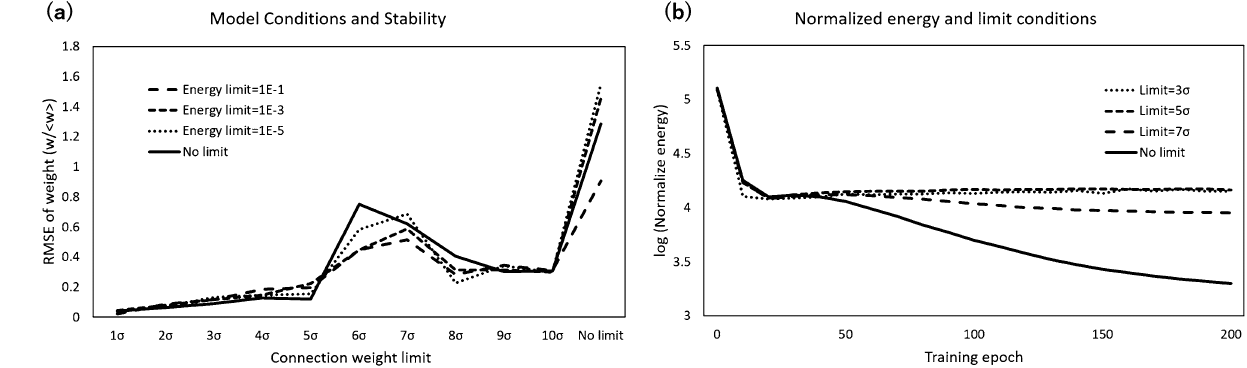
Figure 1. Network stability and energy convergence of the model. ( a ) Network stability. The stability of the network was evaluated by the difference between the networks for each condition. The differences were calculated from the root-mean-square error (RMSE) of the connection weight w as explained in the Methods. The upper limit conditions for the connection weight are listed in the horizontal axis and include values form 1 to 10 times the standard deviation σ as well as the no-limit case; the conditions for the activity cost were set to α = 10 − 1 , 10 − 3 , and 10 − 5 , where α is the ratio to the initial value as explained in the Results section. The averages across 100 networks for these three conditions are shown as solid, dotted and dashed lines, respectively, on the graph. ( b ) Energy convergence. The estimated values of the normalized energy, the target function for the minimization during the network refinement, are plotted for 200 epochs. The simulation was repeated 100 times for each condition, and the averaged values were taken for each 10-epoch bin. In this graph, the different conditions for the upper bound of weight, 3 σ , 5 σ , 7 σ and the no-limit case, were compared at a fixed value of the lower bound for the activity cost, α = 10 − 3